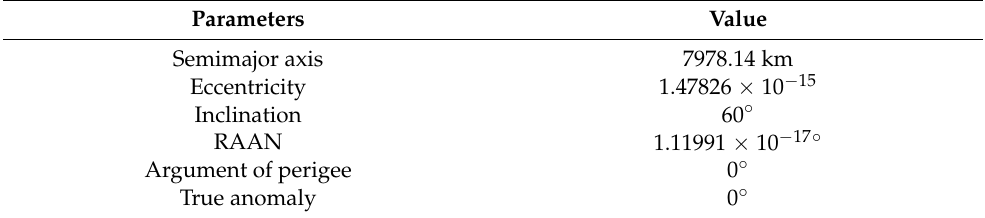
Table 1. Orbital parameters of Satellite1.